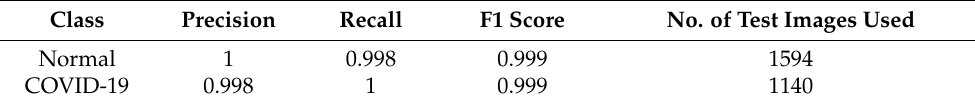
Table 3. Model evaluation on different metrices after using cGAN.